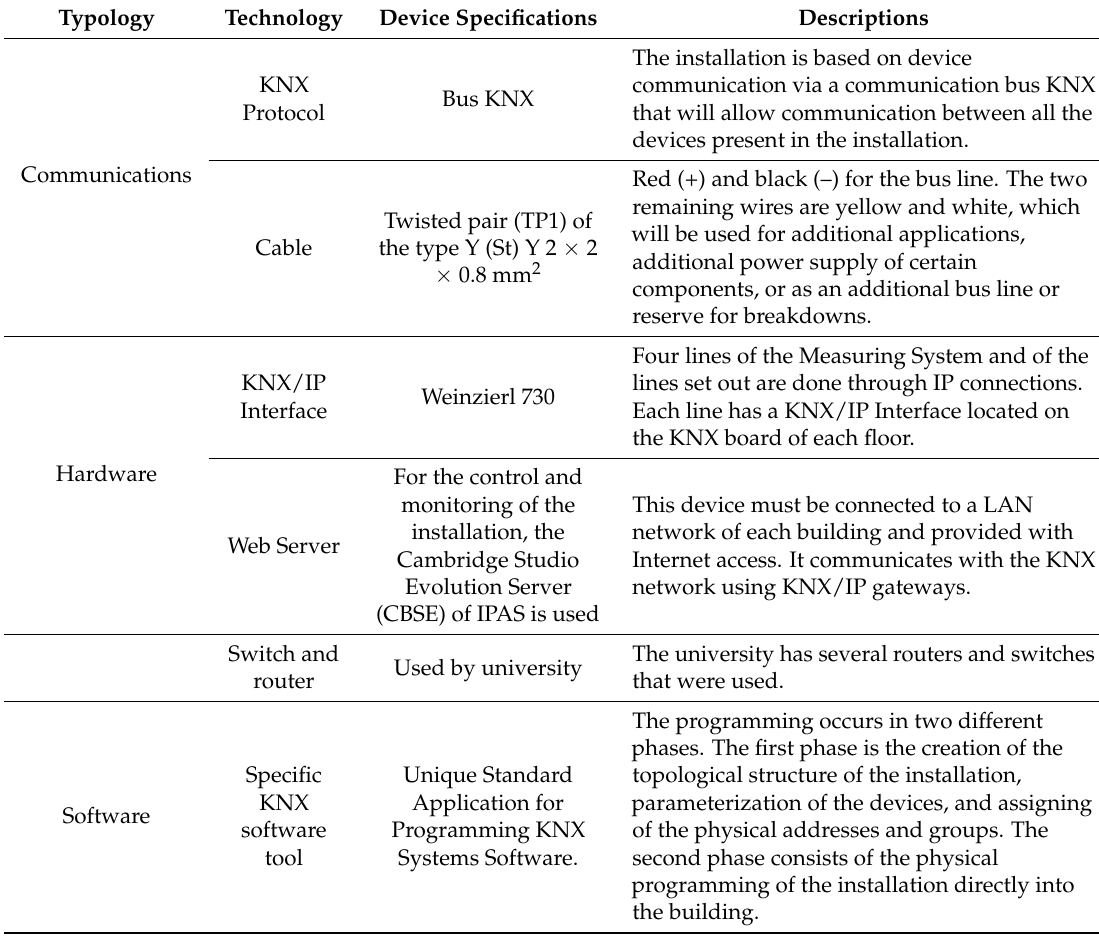
Table 7. Controlling system of a public building of the University of the Basque Country.